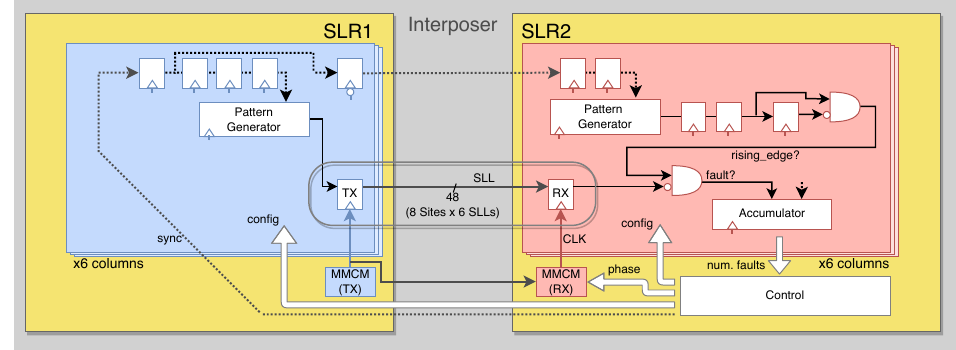
Figure 2: Schematic showing single column of the design. The 48 SLLs are organized in eight Laguna sites, each with six SLLs. The wide control signals are